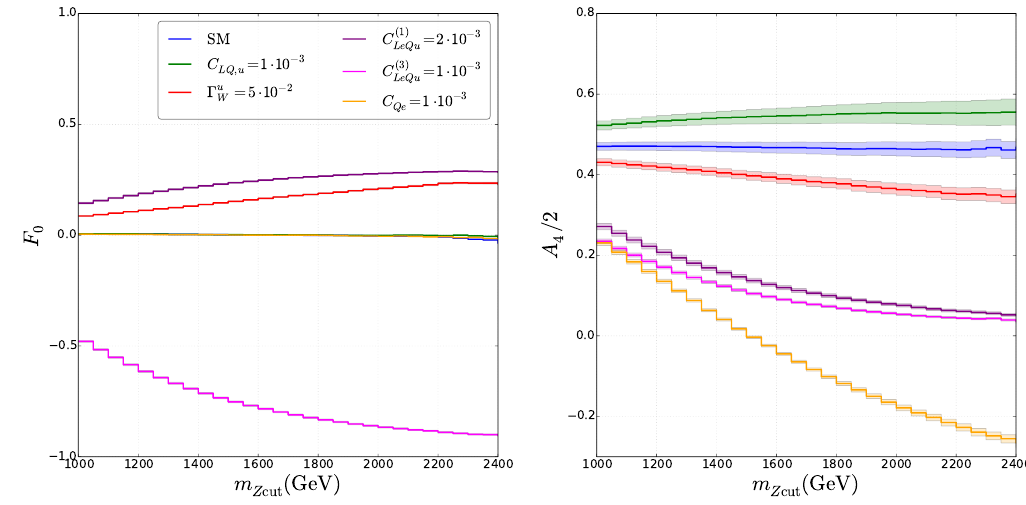
Figure 4 . Longitudinal polarization F 0 and angular coe(cid:14)cient A 4 in pp ! e + e (cid:0) for m Z > m Z cut , where m Z denotes the dilepton invariant mass, at uncertainties from PDF and scale